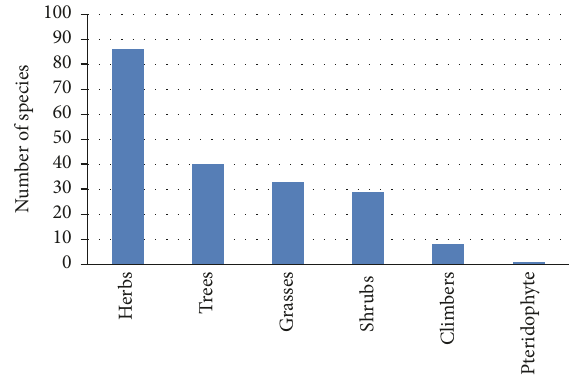
Figure 2: Growth forms observed in Ntabelanga catchment area.